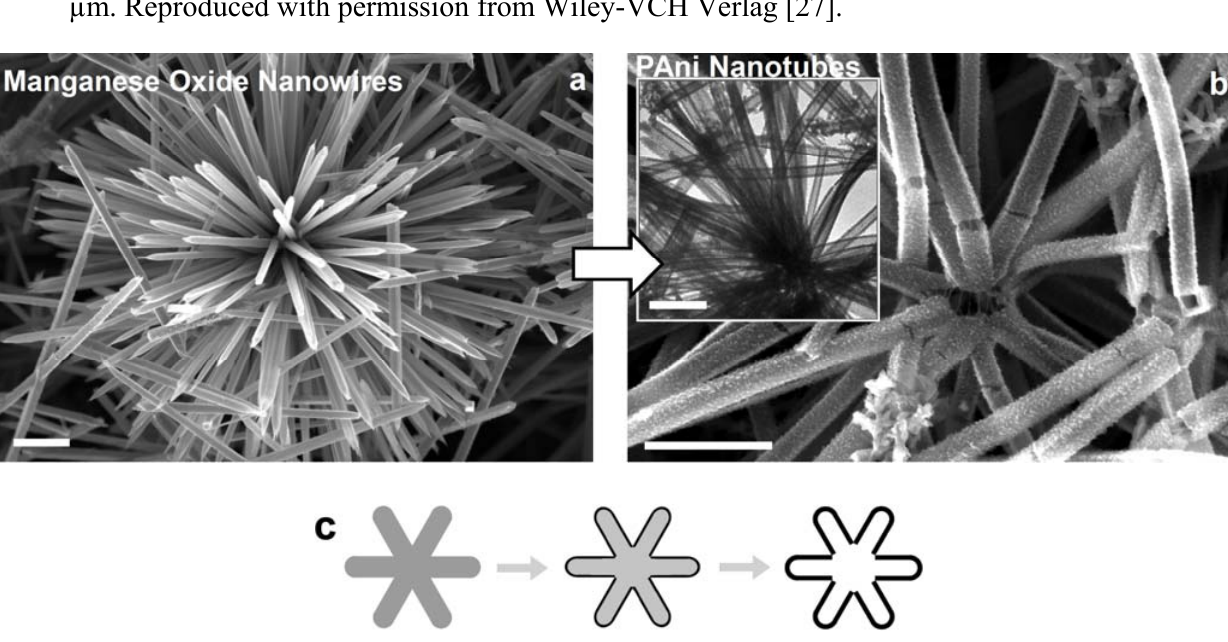
Figure 6. Scanning electron microscopy (SEM) images of a ) cryptomelane-phase manganese oxide template, and b ) resultant polyaniline nanotubes. The inset of (b) is a transmission electron microscopy (TEM) image of the polyaniline nanotubes. c ) Schematic illustration of the formation mechanism of the polyaniline nanotubes. The scale bar is 1 µm. Reproduced with permission from Wiley-VCH Verlag